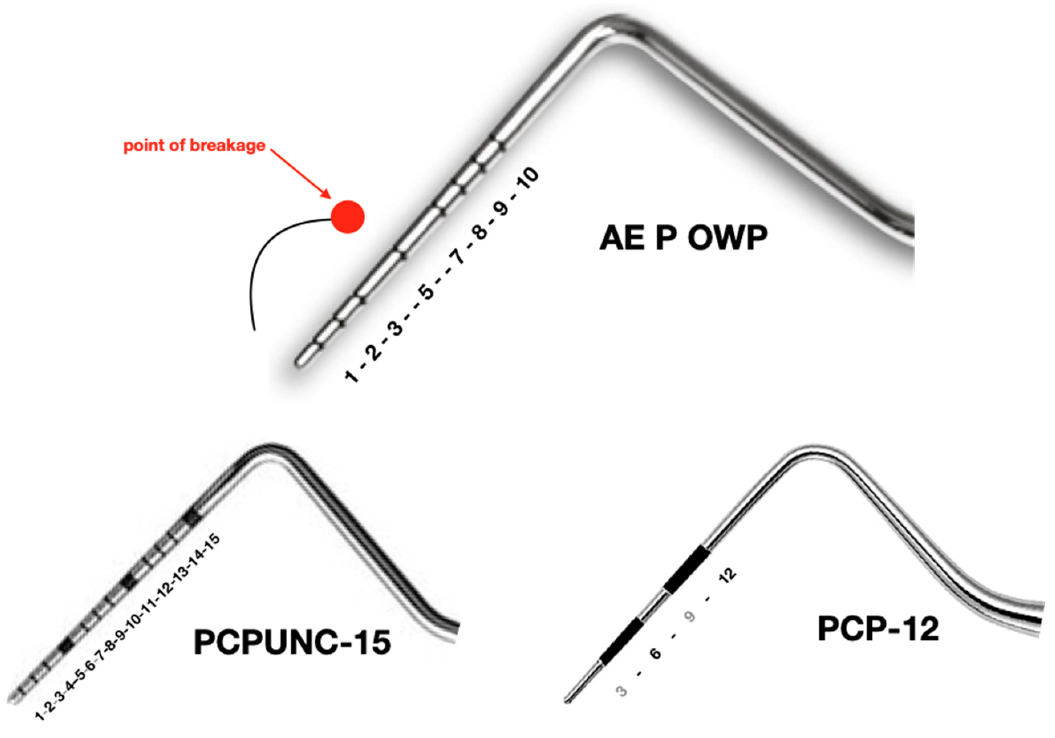
Figure 4. Comparison of the periodontal probes AE P OWP, PCPUNC-15 and PCP-12 (mm markings).